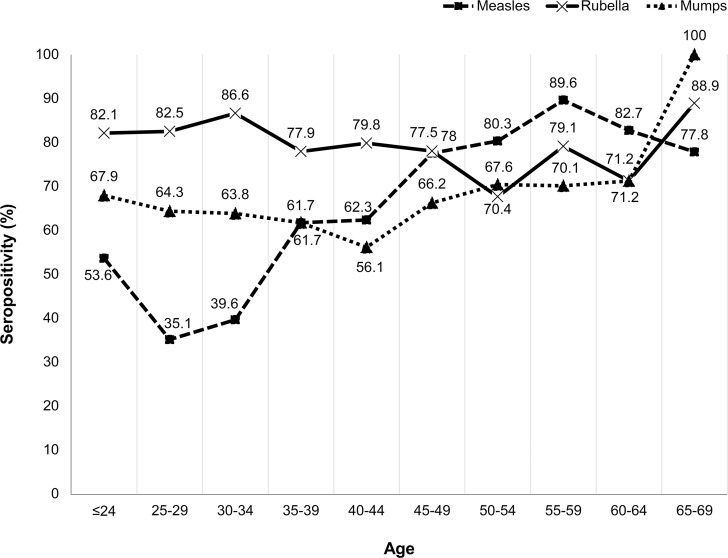
Seropositivity ratio by age groups (males).